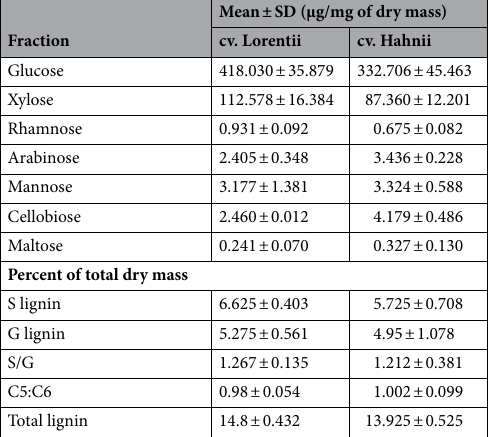
Table 1. Chemical composition of fibers in cvs Lorentii and Hahnii of Sansevieria trifasciata . Carbohydrates were quantified by HPAEC-PAD and lignin monomers by py-MBMS. Values are means ± SD. Means followed by different letters indicate a significant difference between fractions of both cultivars according to Tukey’s test ( p ≤